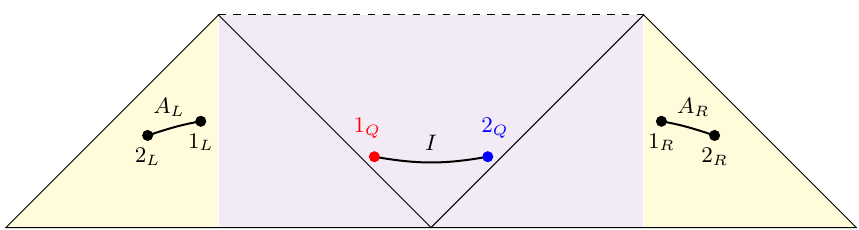
Figure 12 . The island saddle in regime (III) ∪ (IV) has an island with QES behind the horizon as shown in red and